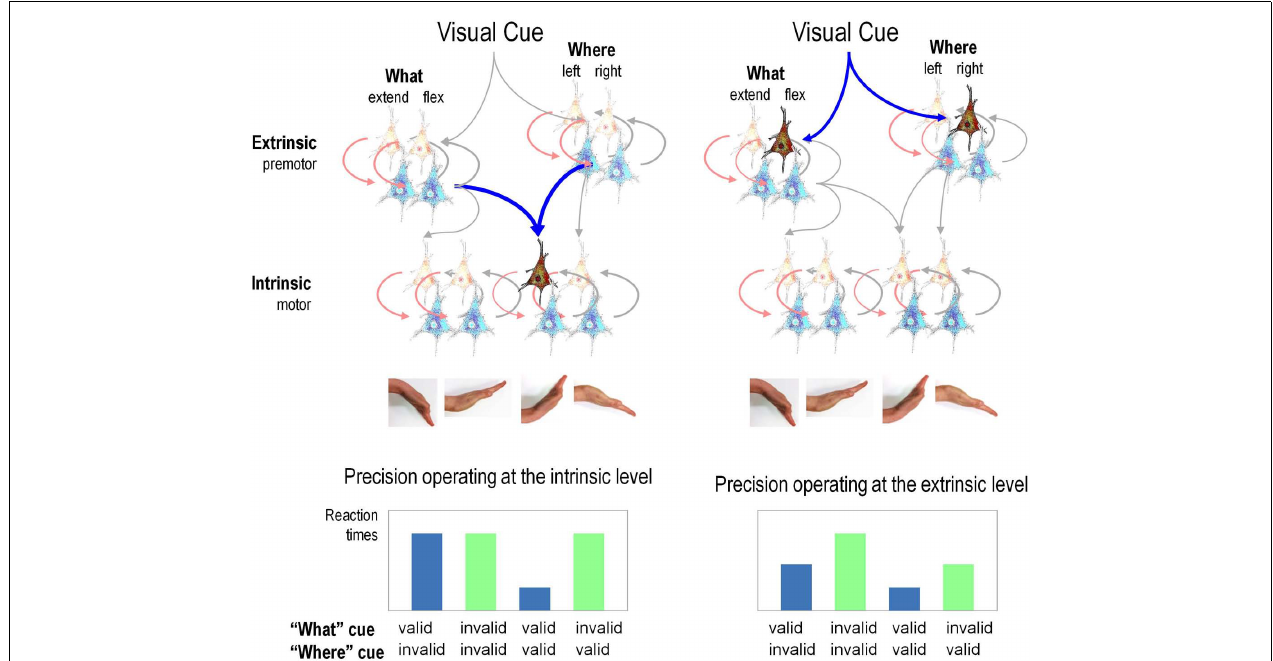
movement dimensions; e.g., all left-hand movements and all inward movements. In this figure, darker units highlight prediction-error units with increased gain.The lower graphs show the predicted profile of reaction times (under valid and invalid cueing) for cueing at extrinsic (right) and intrinsic (left) levels. In the intrinsic (motor cortex) model, there should be an interaction between the validity effects of cues over both movement dimensions. In other words, the benefit using the expected hand will only be seen if the expected movement is required. Conversely, under the extrinsic (ventral premotor cortex) model, there should be no interaction but two main effects due to the validity of what and where aspects of the movement